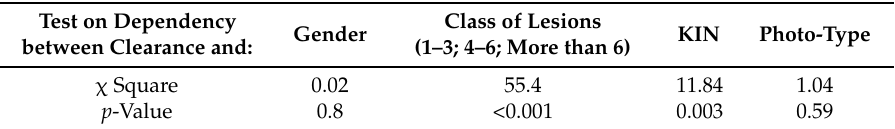
Table 2. Value of the χ -square index and of its associated p -value for full or partial clearance and gender, class of lesions, localization of lesions, KIN and photo-type.